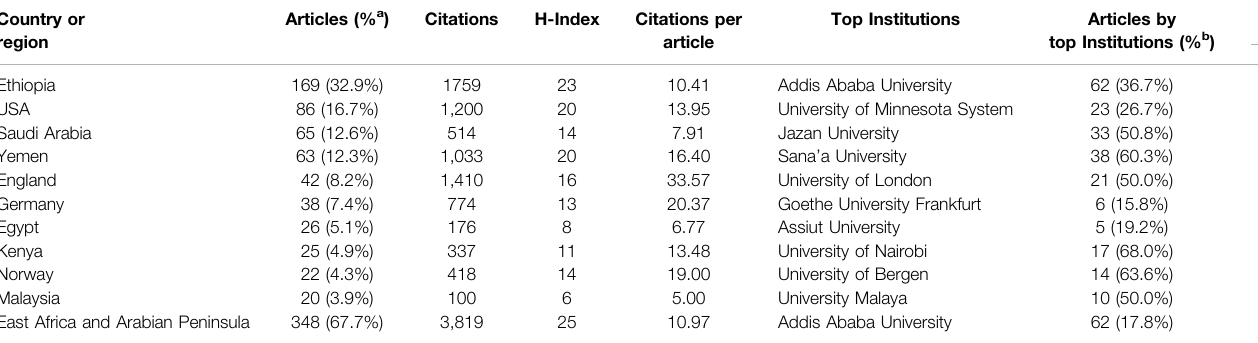
TABLE 1 | The top 10 most productive countries and institutions for Catha edulis publications. Country or